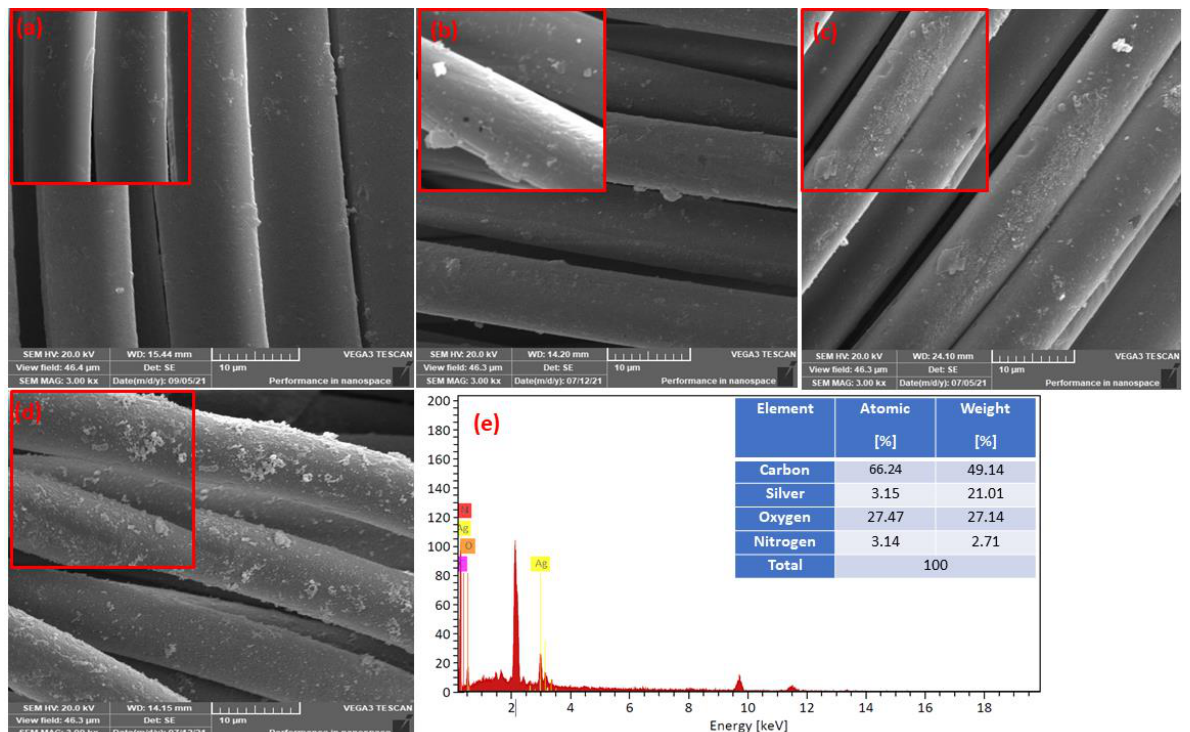
Figure 4. Low and high magnification FESEM images of ( a ) PET, ( b ) PET hydrazide, ( c ) PET hydrazide-AgNP-PDA, and ( d ) PET hydrazide-AgNP, with ( e ) the SEM – energy-dispersive X-ray (EDX) spectra of PET hydrazide-AgNP-PDA.